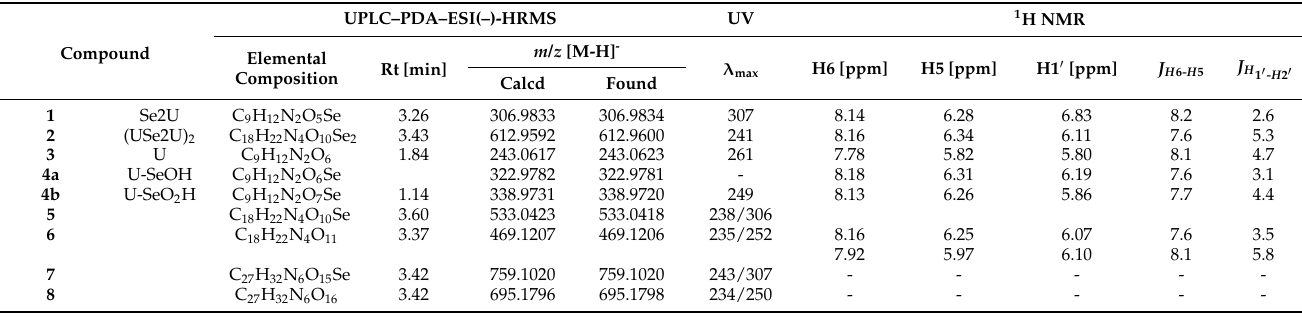
1 H NMR data not available.